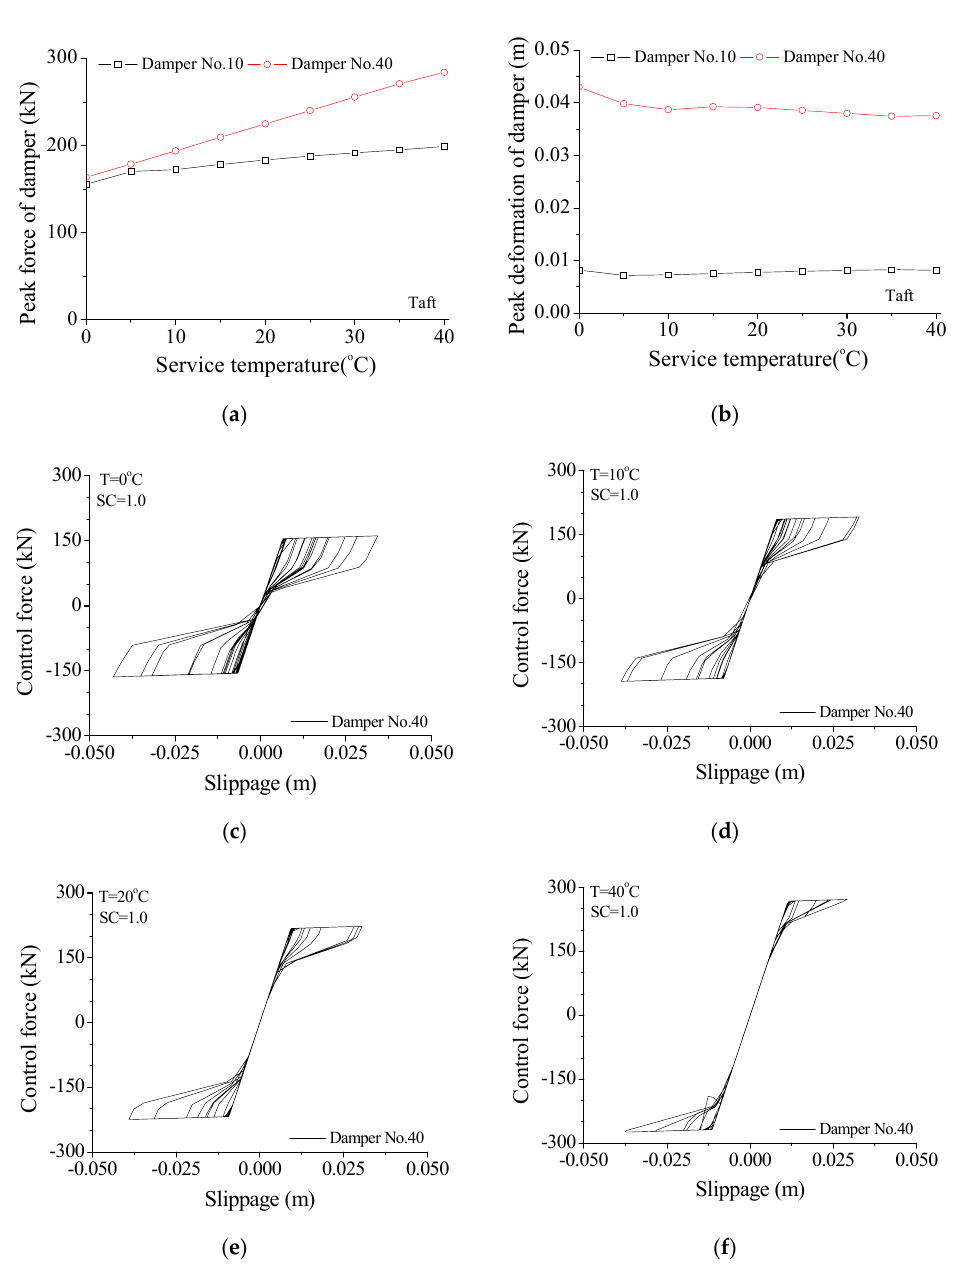
Figure 11. Variation of damper force and deformation with service temperature. ( a ) Peak force; ( b ) Peak deformation; ( c ) T = 0 º C; ( d ) T = 10 º C; ( e ) T = 20 º C; ( f ) T = 40 º C.